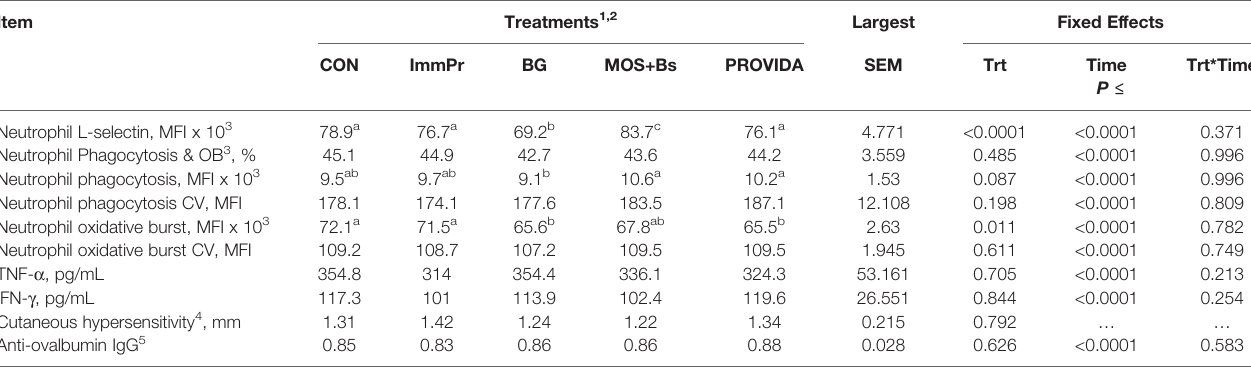
TABLE 5 | Effects of treatment on hematology measurements in high-risk Holstein dairy calves.